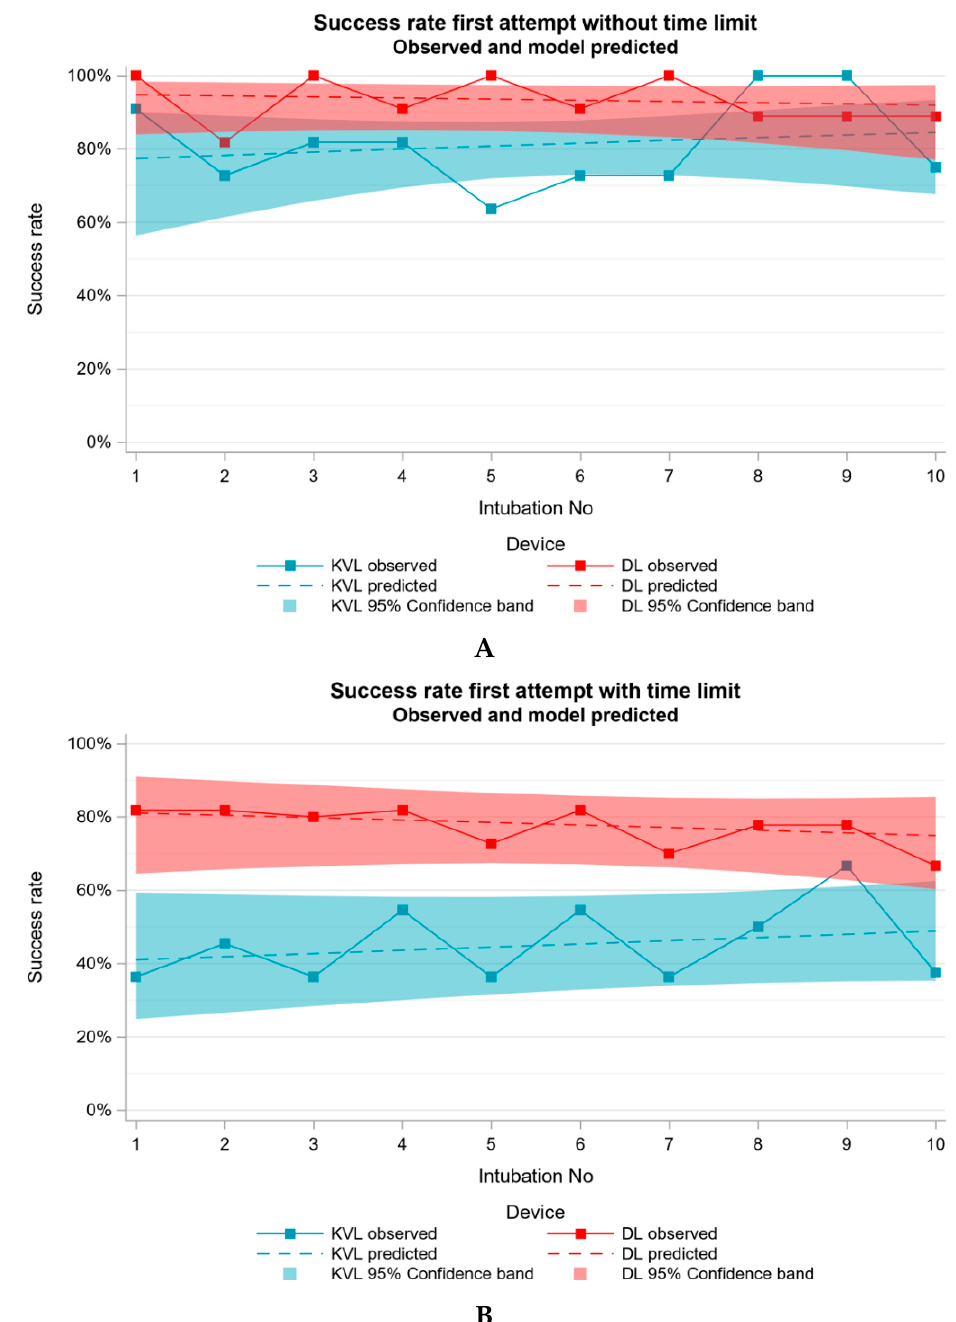
Figure 3. Observed learning curves and learning curves predicted from a generalized estimating equations logistic regression, which was performed to evaluate the progress of each trainee with increasing number of intubations. ( A ) Success rate without time limit, ( B ) with time limit.